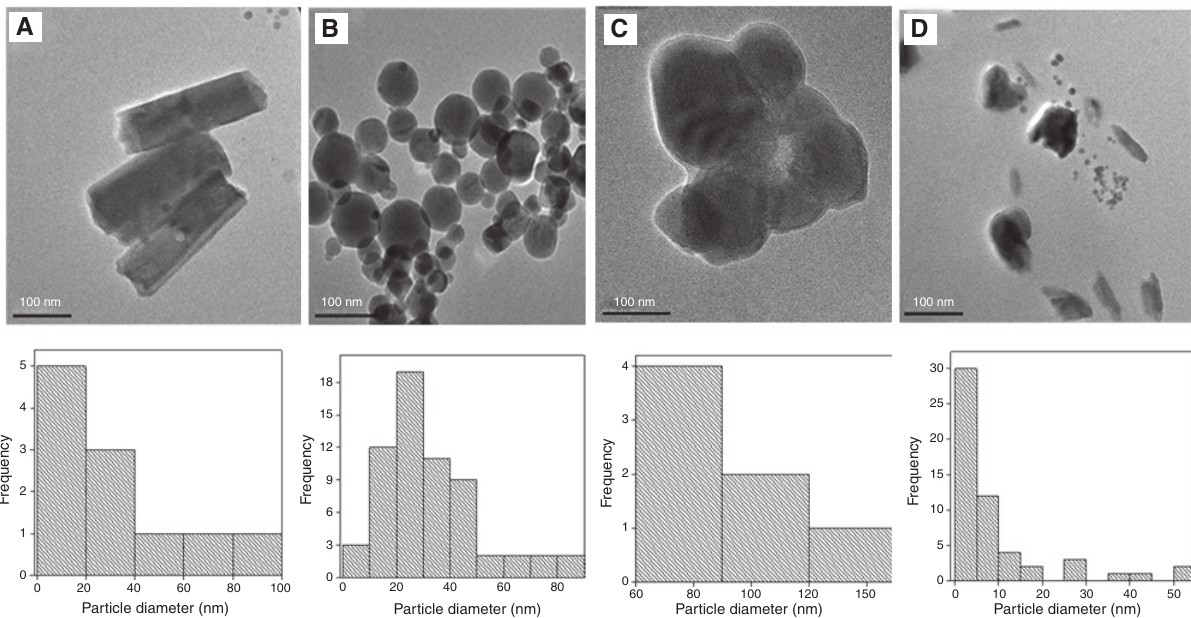
Se nanoparticles capped with 1.0% (w/v) of 2